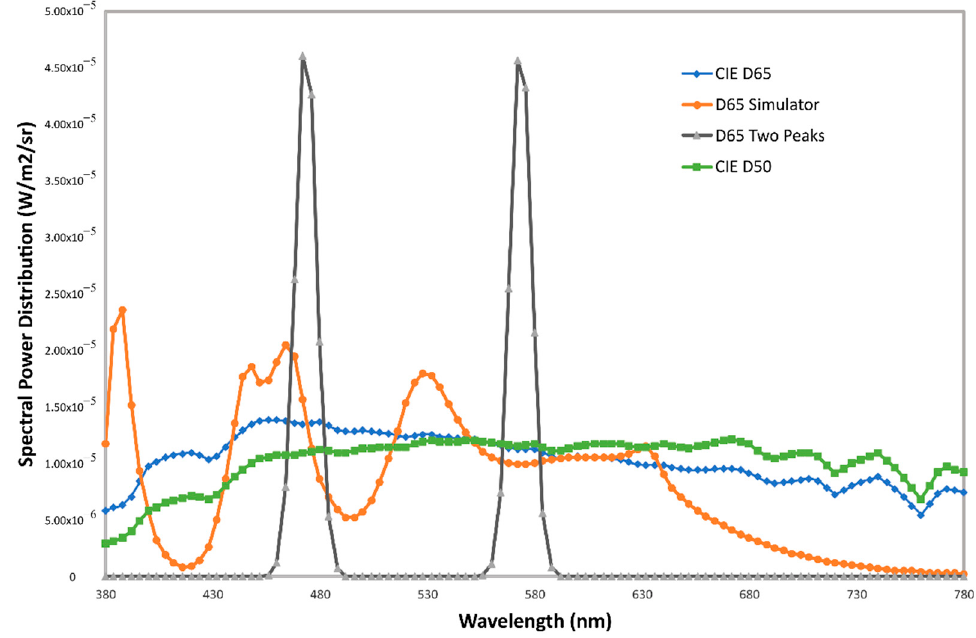
Figure 7. Spectral power distribution of the light sources employed in this work adjusted to a luminance value of 85 Cd/m 2 .